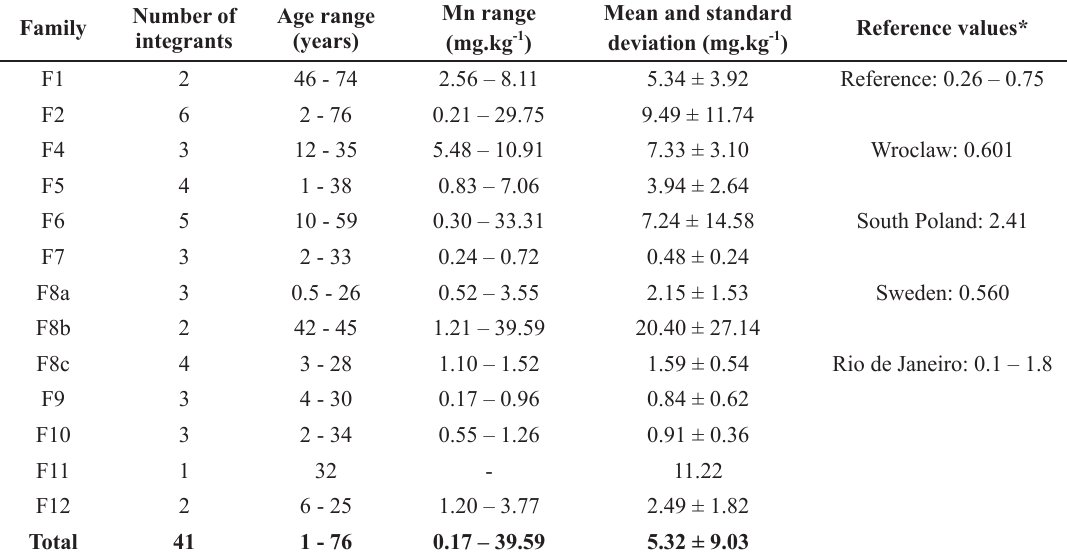
Human hair levels of Mn in family